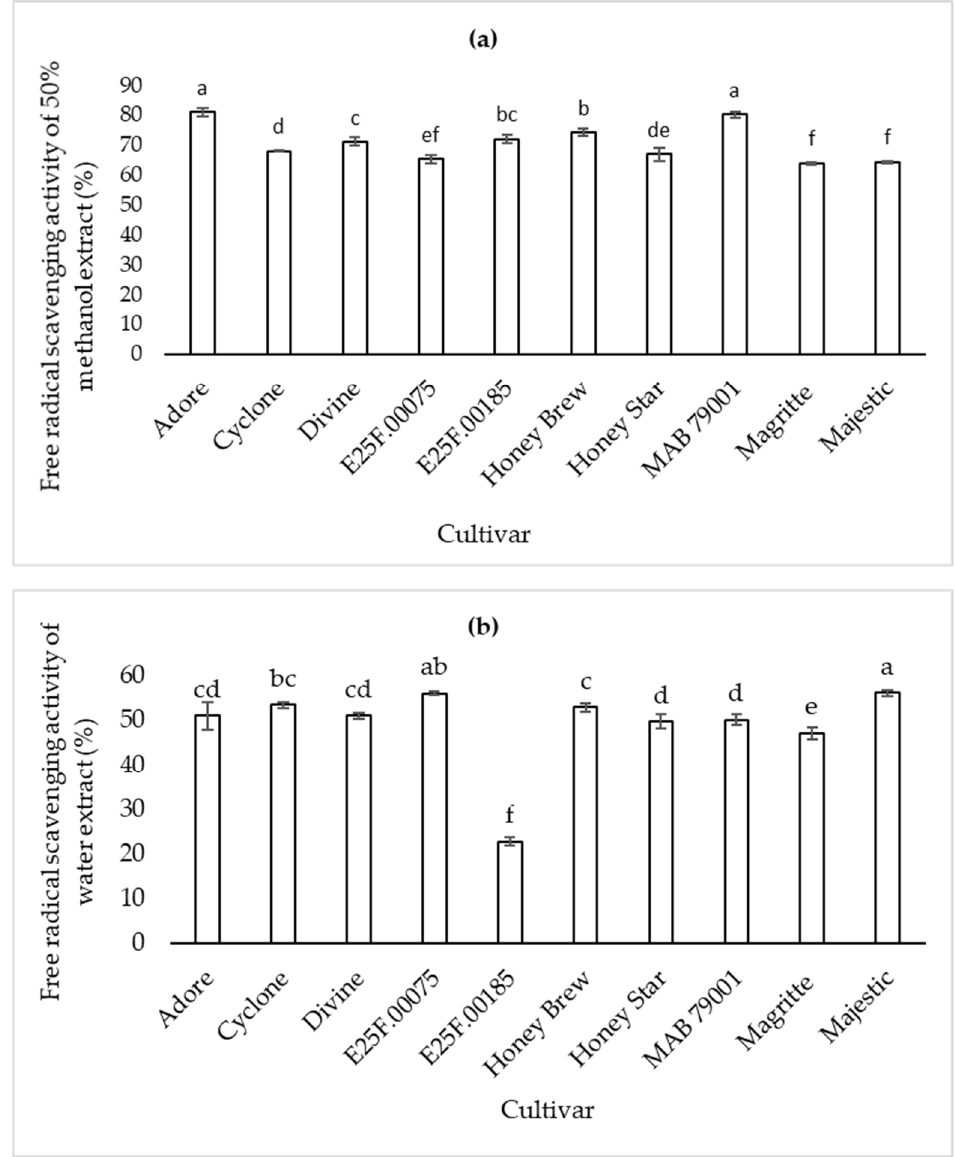
Figure 3. Free radical scavenging activity of 50% methanol ( a ) and water ( b ) extracts of fruit from sweet melon cultivars at harvest. Bars (with error bars indicating standard error of means) with different letters are significantly different at p ≤ 0.05 (Fisher’s protected LSD test, n = 4).